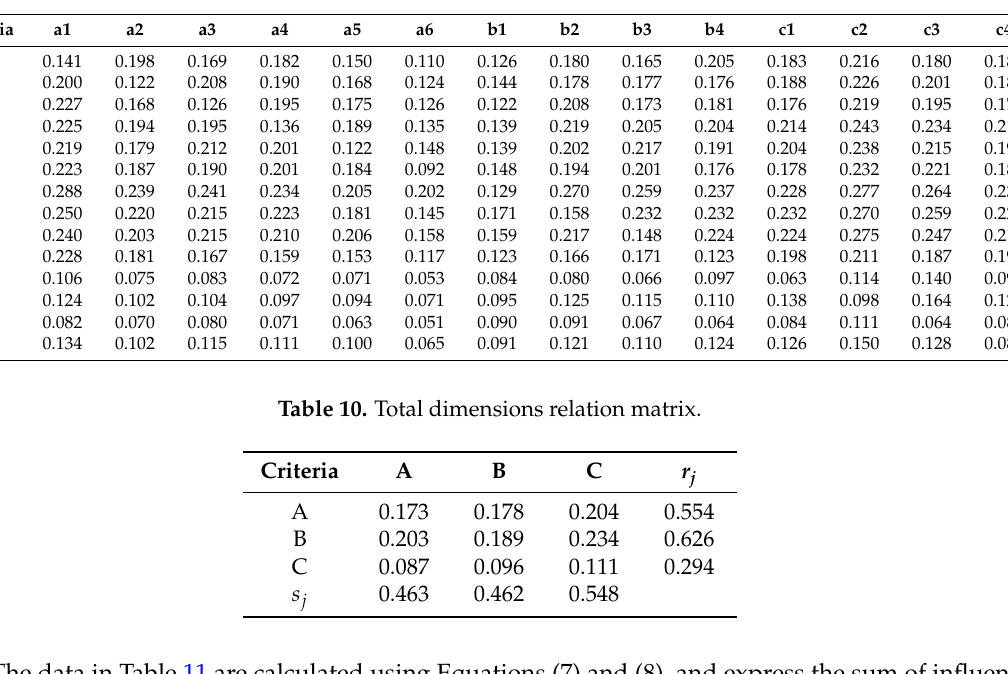
Table 9. Total criteria relationship matrix.